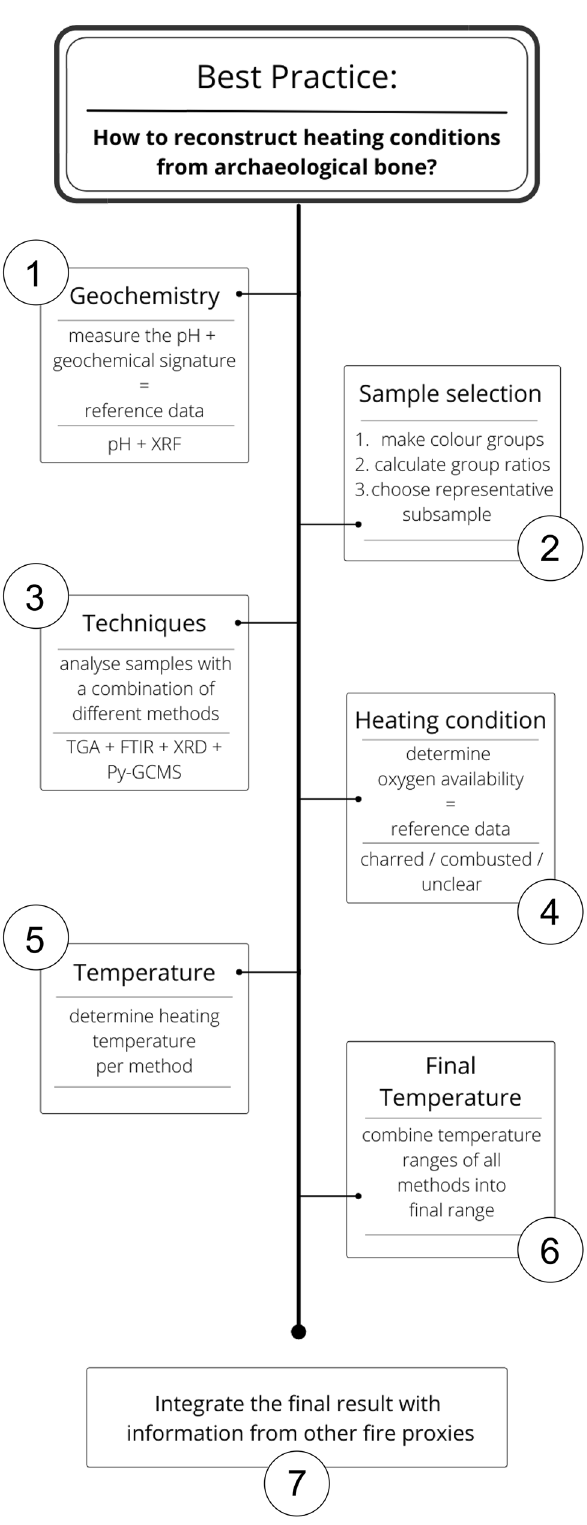
Figure 6. Flow chart displaying the best practice for the study of archaeological heated bones for fire-related research questions, explicitly taking the effect of diagenesis into